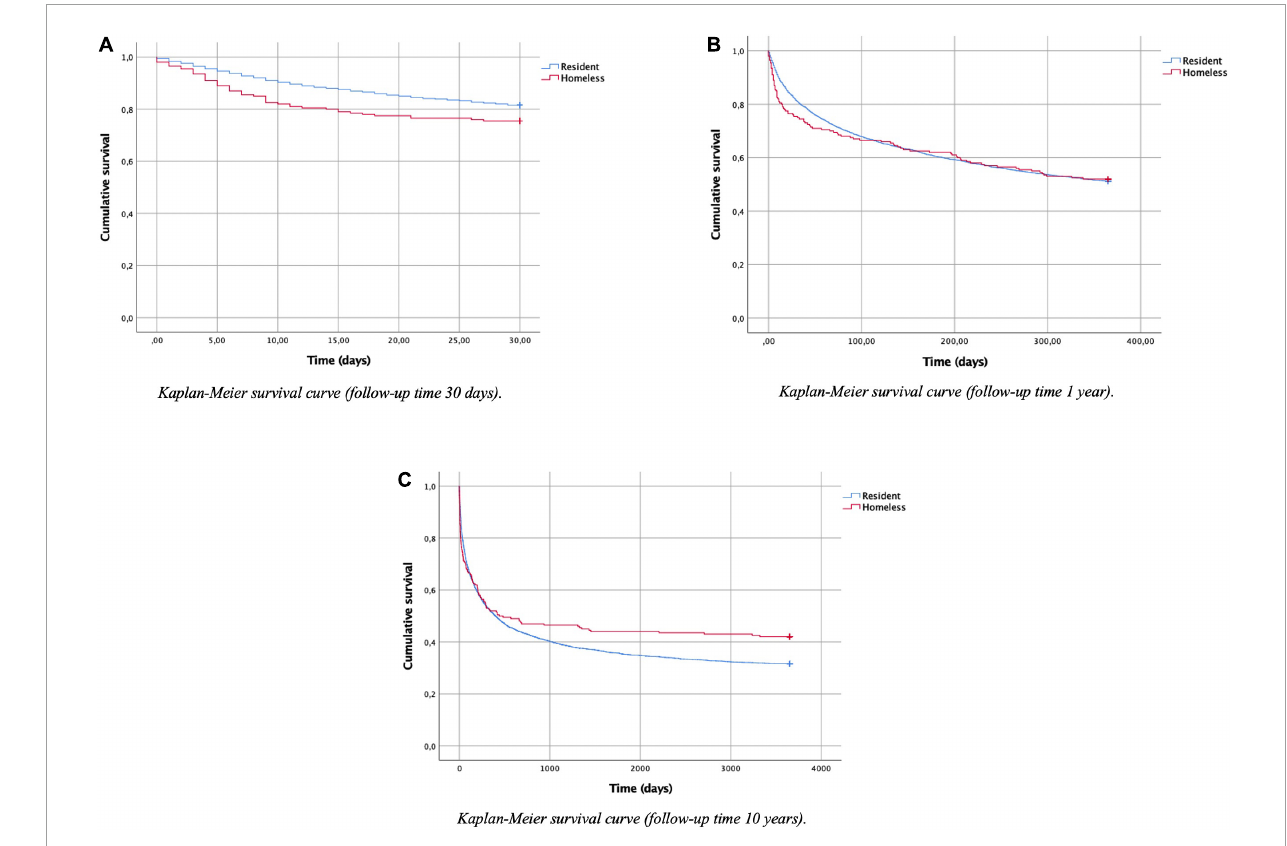
FIGURE1 Kaplan-Meier survival analysis representation. (A) Kaplan-Meier survival curve (follow-up time 30 days). (B) Kaplan-Meier survival curve (follow-up time 1 year). (C) Kaplan-Meier survival curve (follow-up time 10 years).